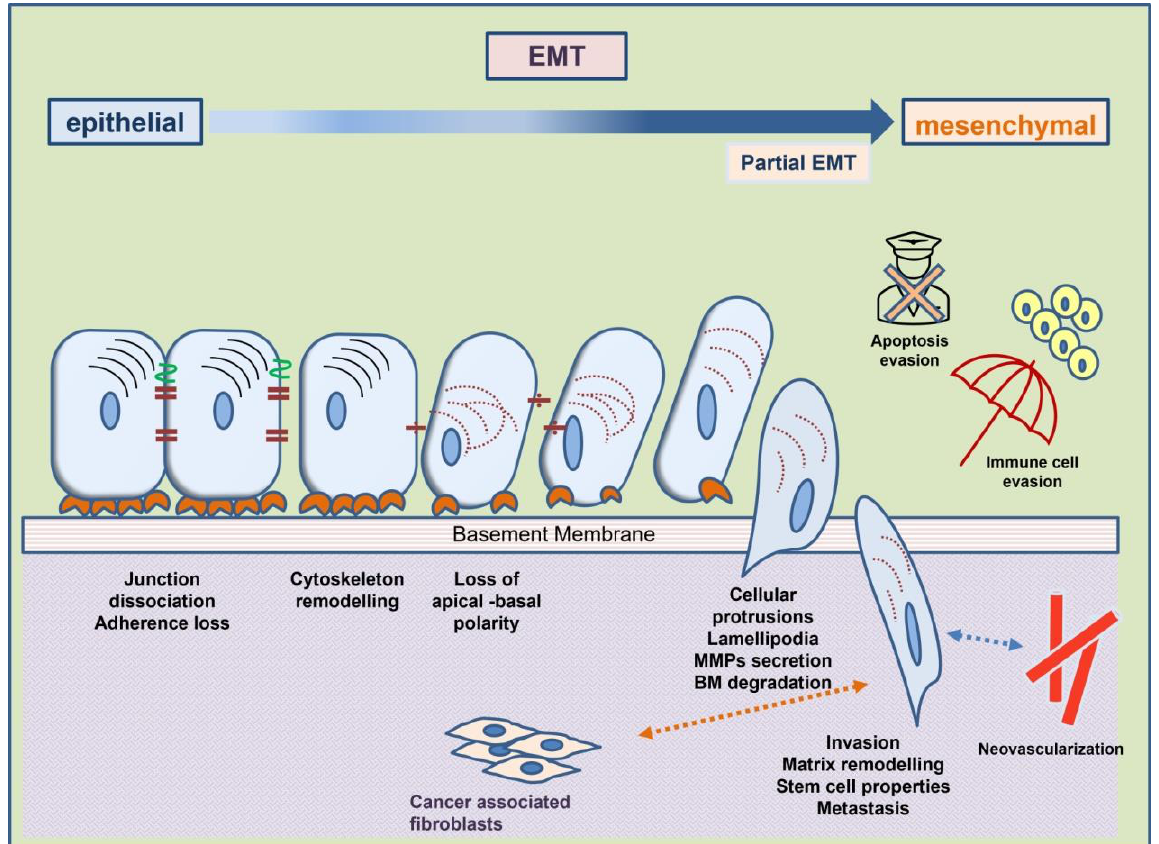
Figure 1. Cellular phenotypic changes and acquired mesenchymal characteristics in the course of mesenchymal-to-epithelial transition provide tumor cells with increased metastatic properties. Interaction with the tumor microenvironment is an important